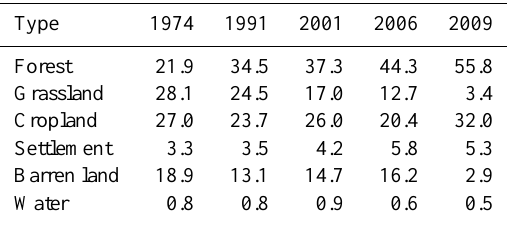
Table 7. Percent of land cover types in the Kejie watershed